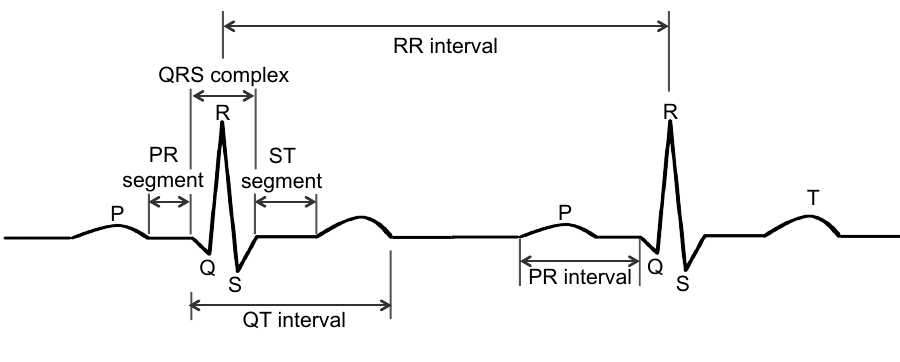
Figure 1. Structure of